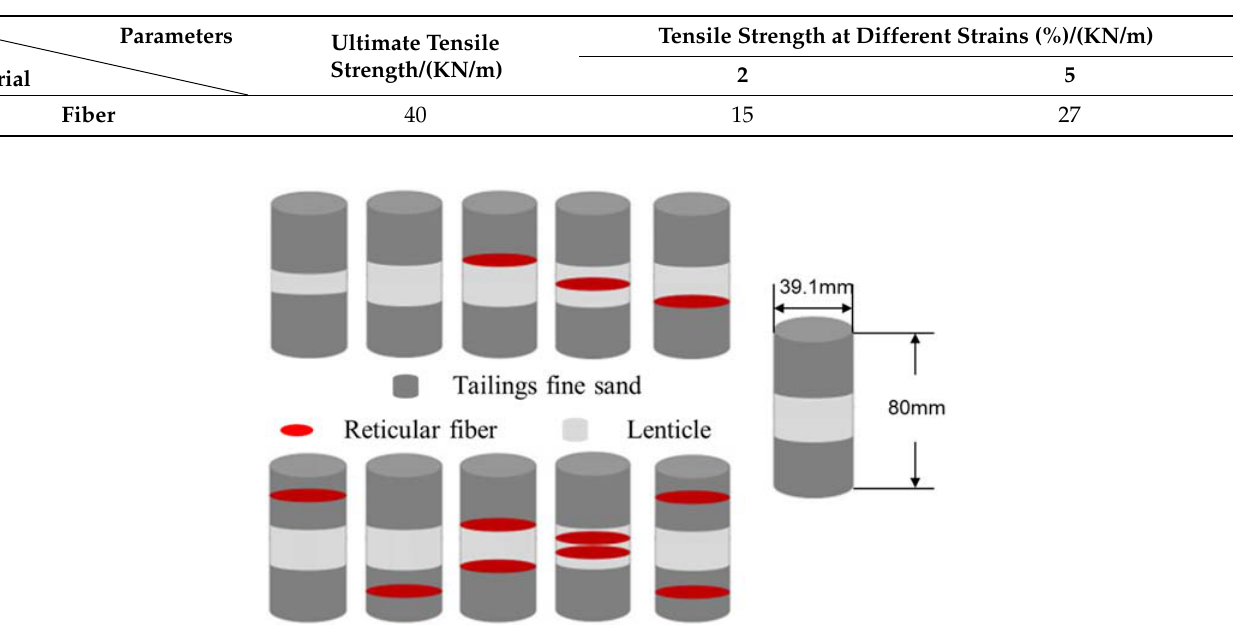
Figure 2. Reticular glass fiber. Table 2. Strength indexes of unidirectional glass fiber.